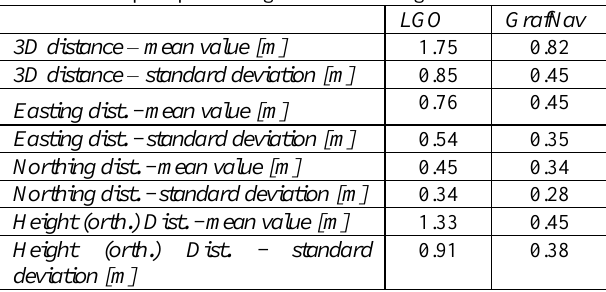
Table 3. Differences between the GPS results from differential post-processing and the tracking data.